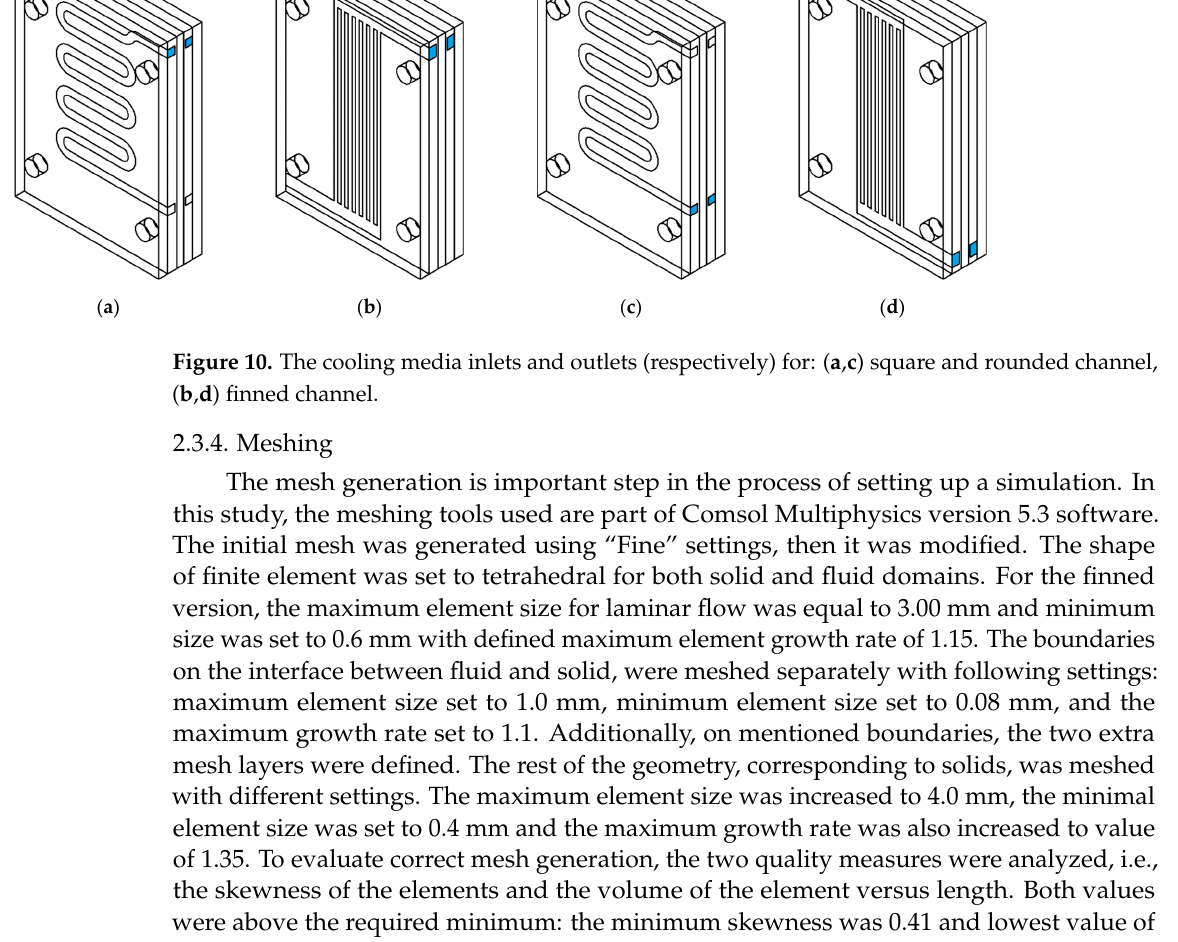
Table 2. The comparison of mesh values.